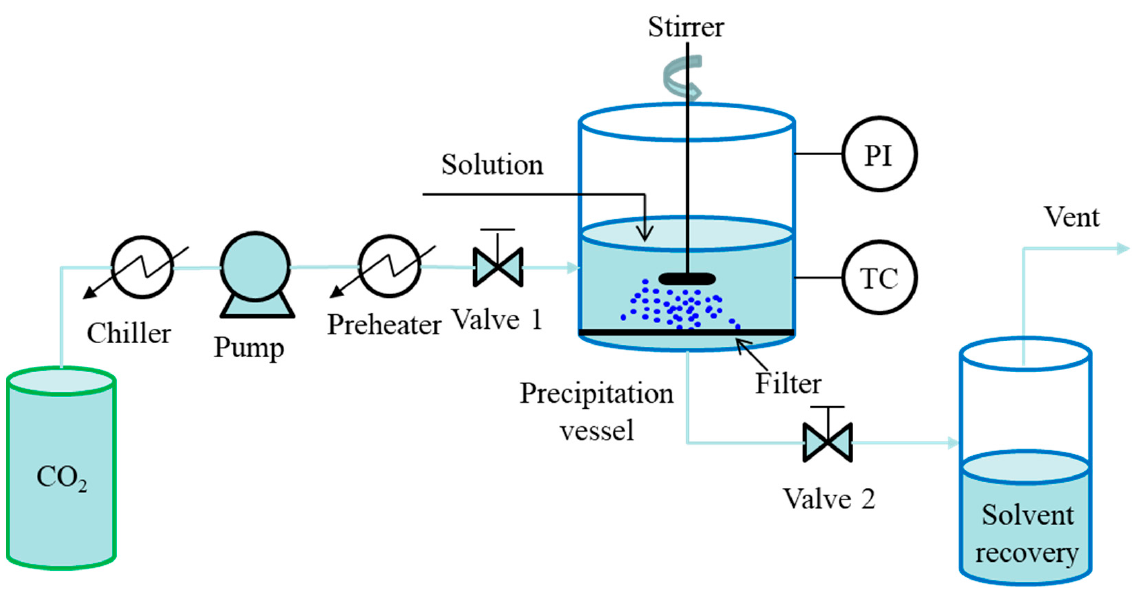
Figure 2. Schematic diagram of batch SAS process: GAS process.